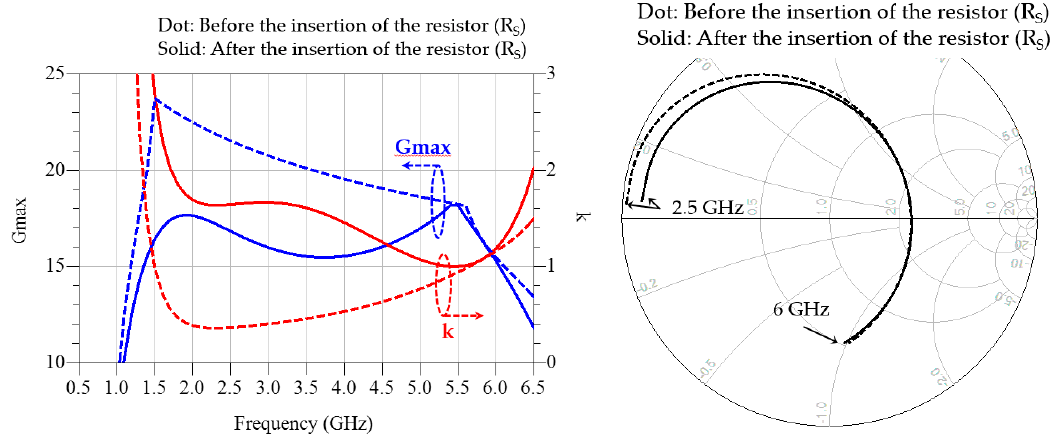
Figure 4. Variation of the stability factor k, maximum available gain (G max ), and input impedance after the insertion of the series resistor R S , with the shunt resistor attached.